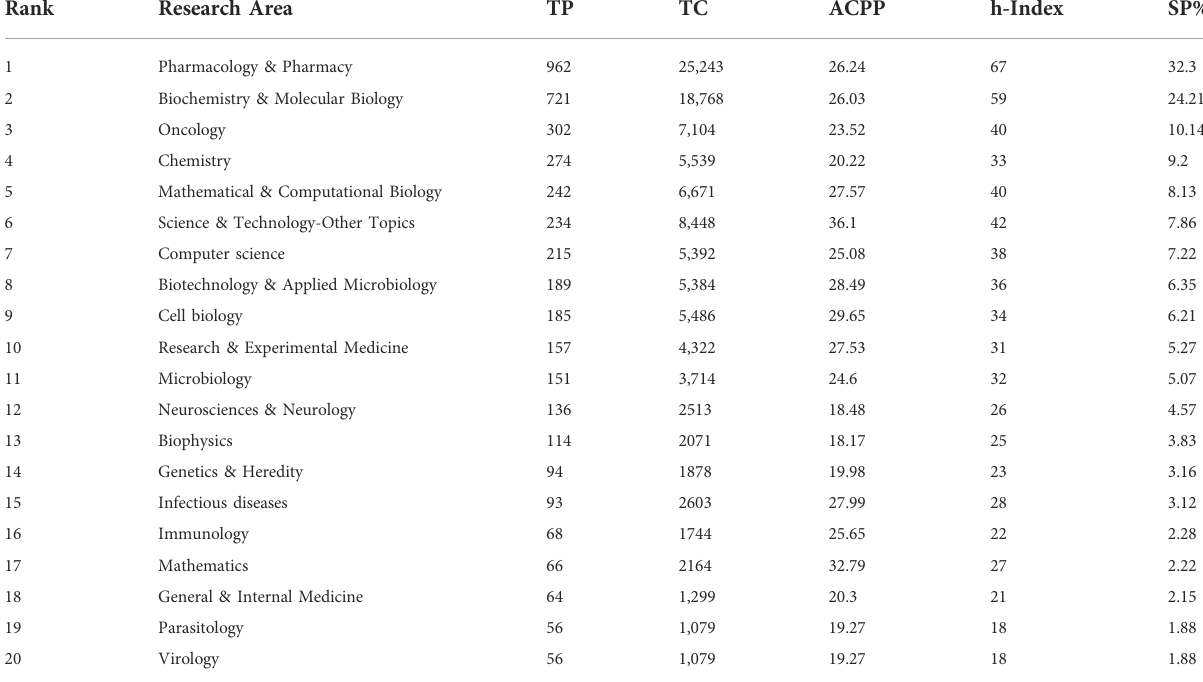
TABLE 3 Contribution of the top 20 research areas in the fi eld of drug